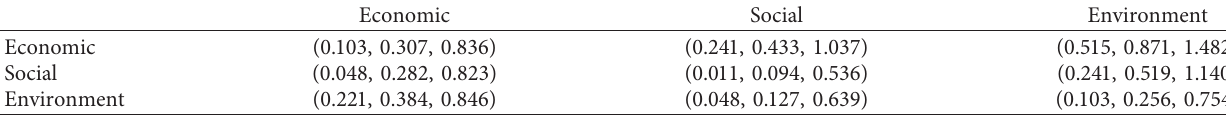
Table 18: Total relationship matrix of sustainability dimensions in Z-number condition.